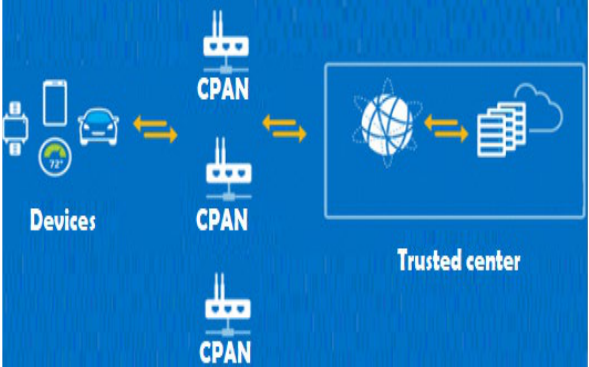
Figure 1. Network model of proposed